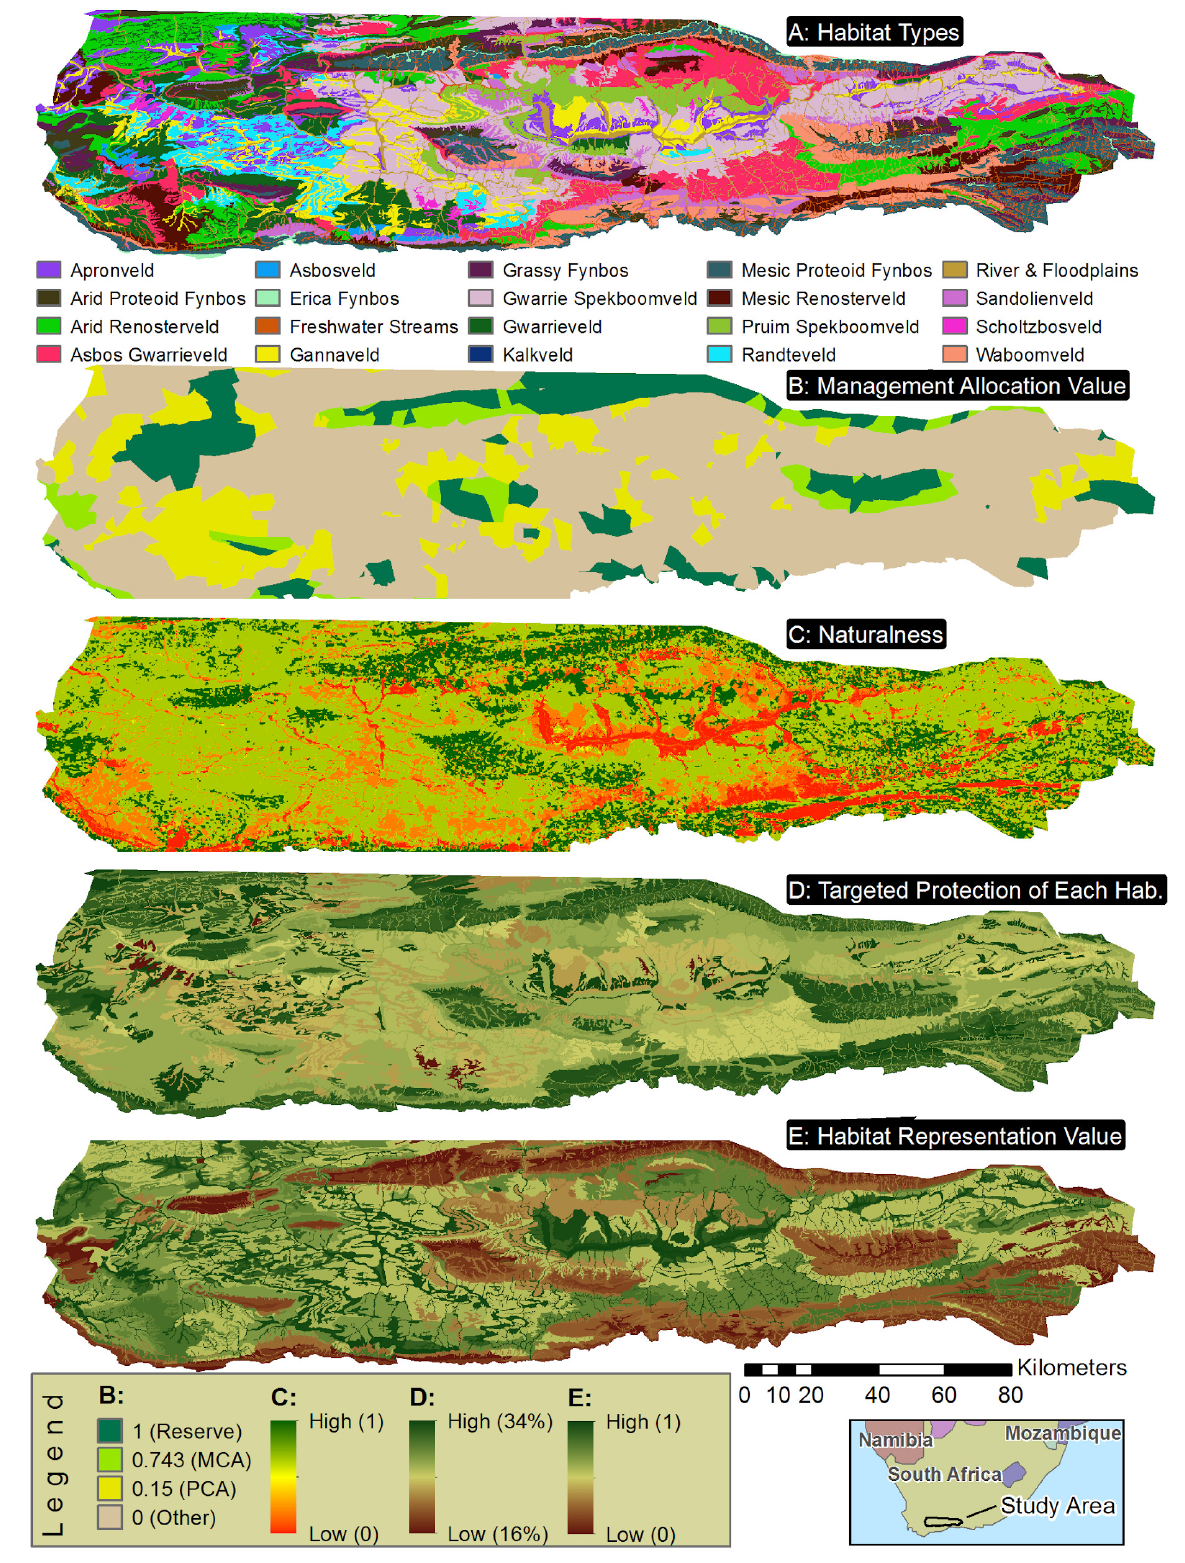
Figure 11. Input data and first iteration outputs for habitat representation. High representation value for a location indicates a high conservation priority for this criterion. Target values were determined in a previous study based on species richness estimates (see Metadata in Supplementary Information). MCA = Mountain Catchment Area, a multi-use land protection. PCA = Private Conservation Area, i.e., a pre-existing privately owned stewardship area.